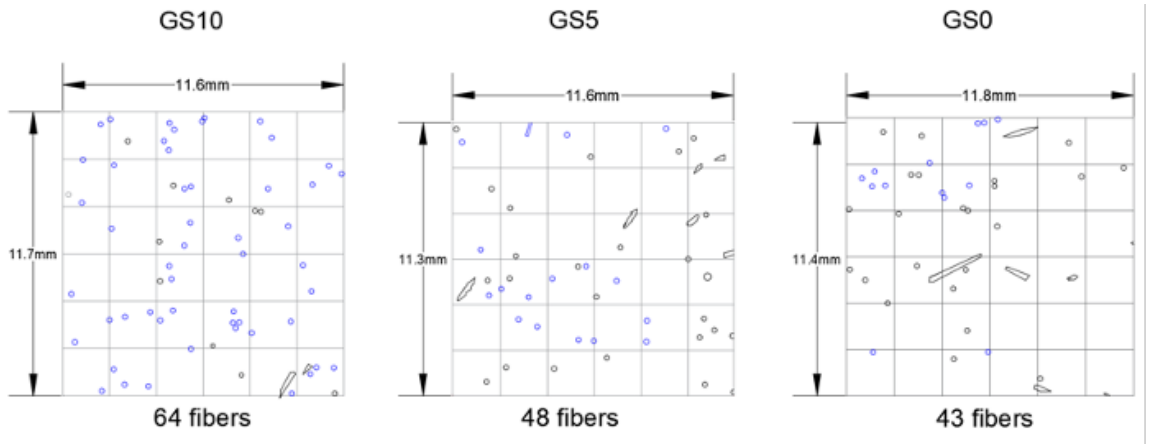
Figure 4. Schematic of thin section QEMSCAN images and the number of fibres per cross